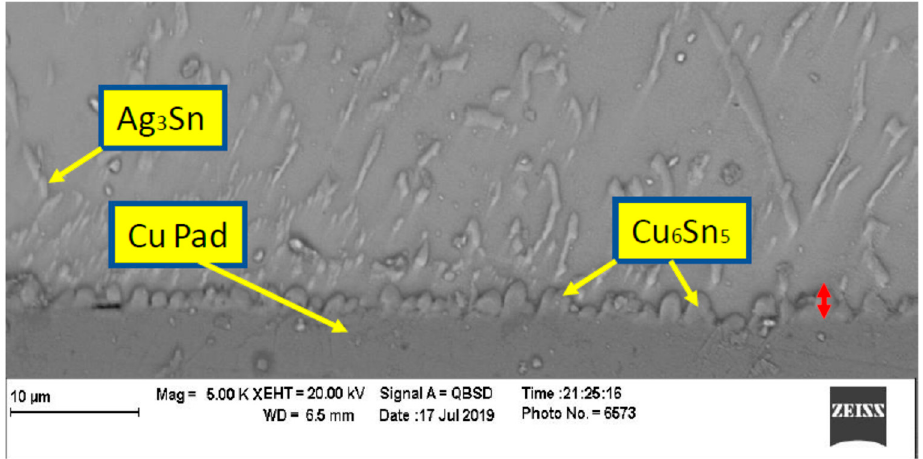
Figure 5. Microstructure of SAC305 fused to a copper pad as prepared (no aging).